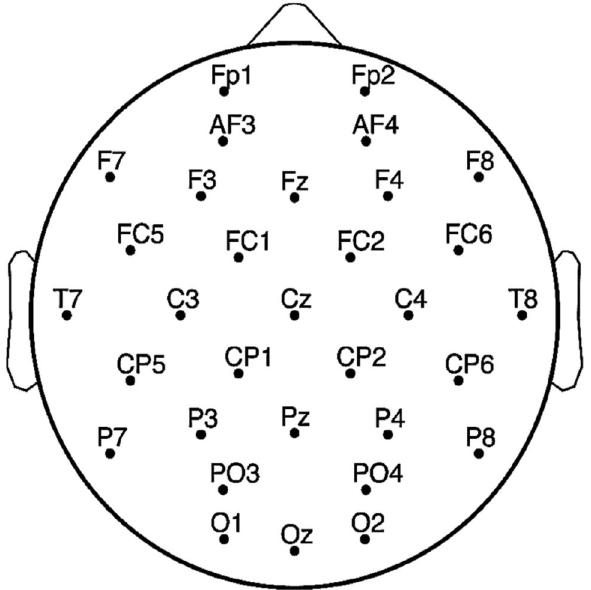
Figure 7. EEG channels